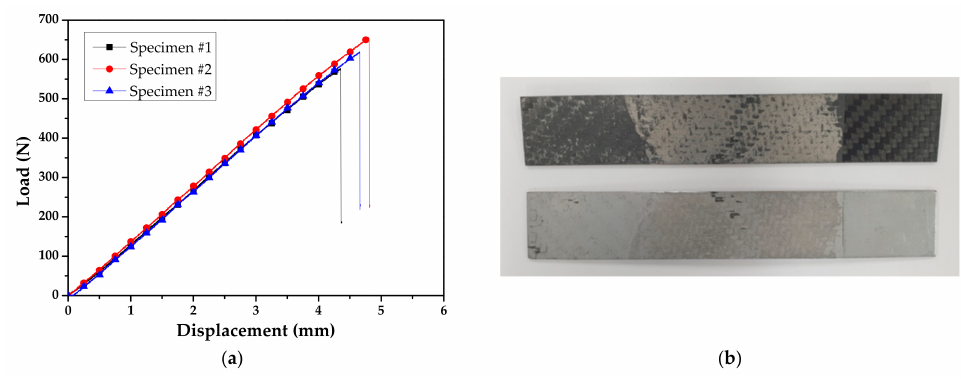
Figure 6. Results of ENF test: ( a ) load–displacement curve; ( b ) failure surface. The flexural modulus is expressed by Equation (4), and the energy release rate of mode II is expressed by Equations (5) and (6).